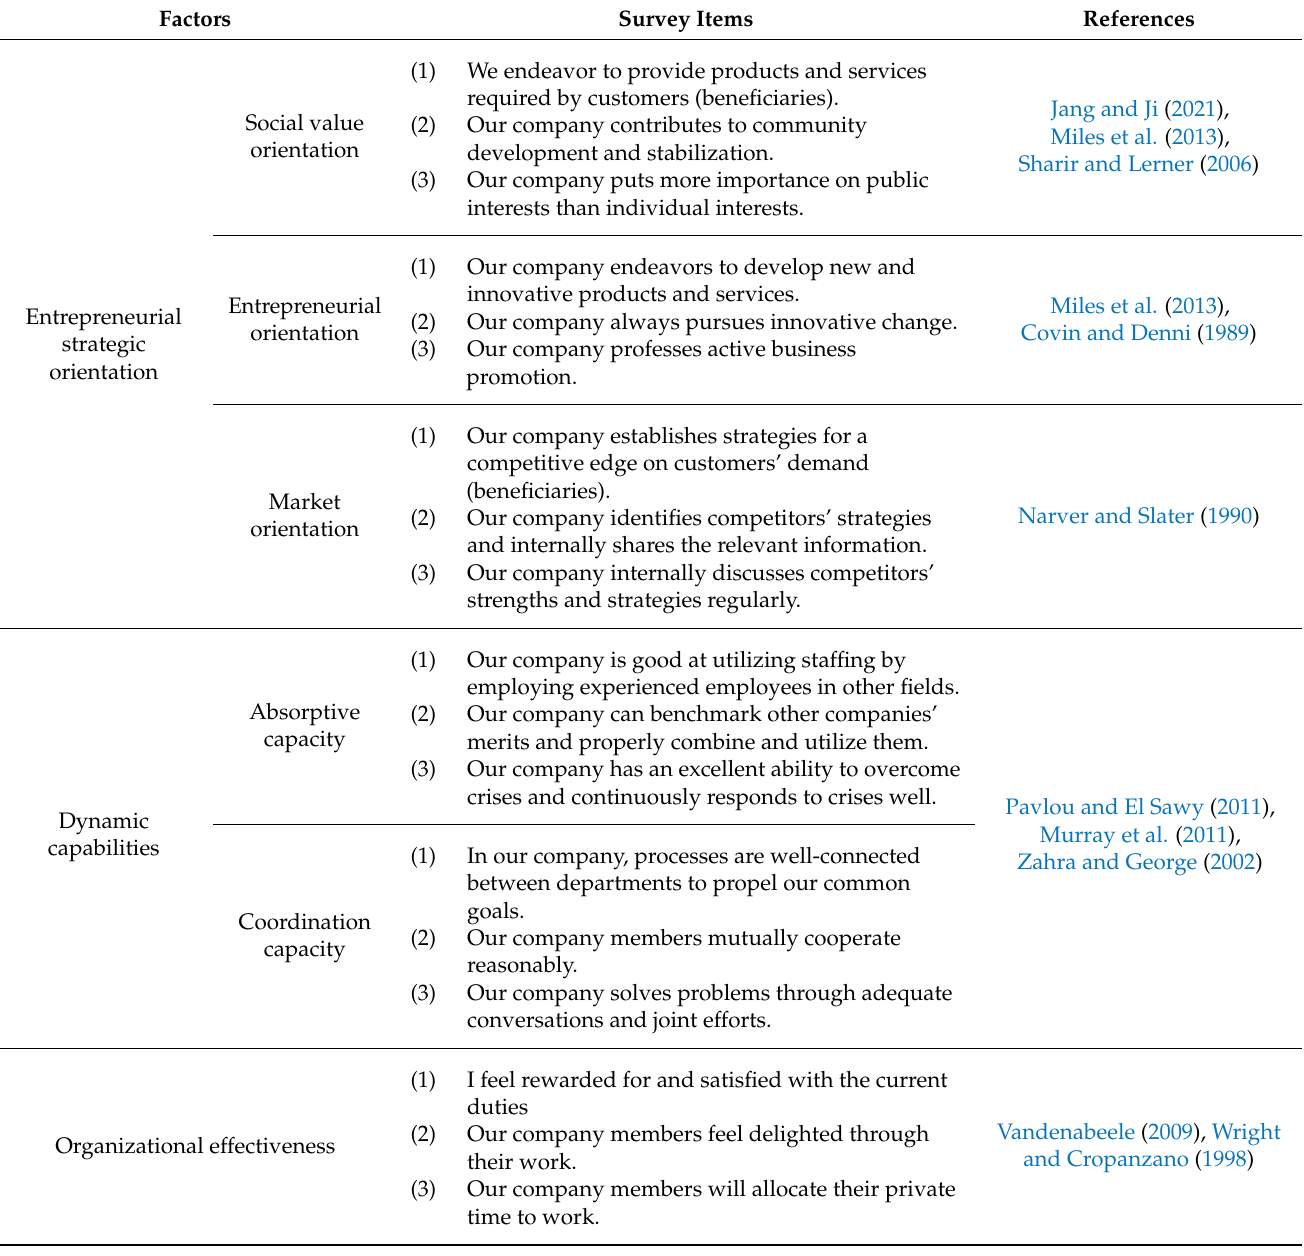
Table 1. Variables and measurement